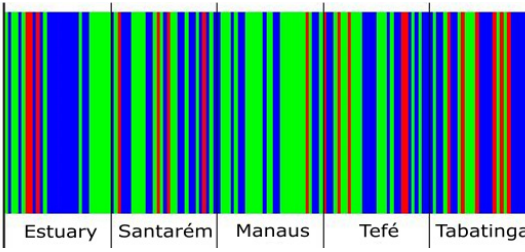
FIGURE 3 | Analysis of the BAPS 6.0 program showing three clusters (green, red, and blue) distributed between the five sampled locations of Brachyplatystoma vaillantii .